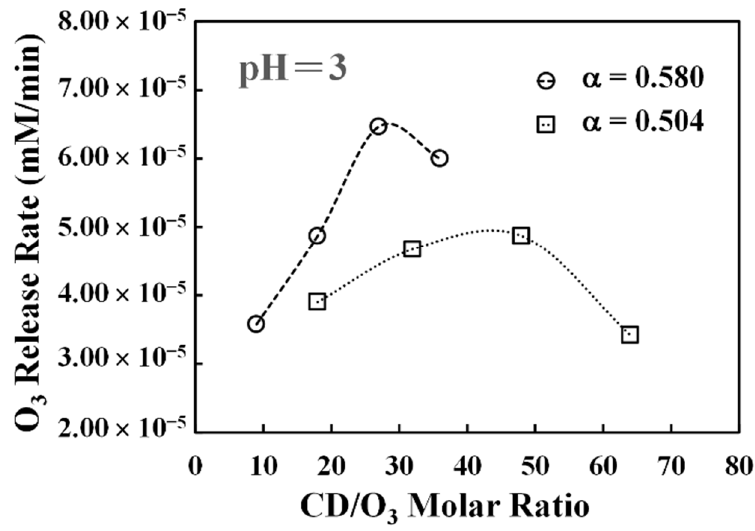
Figure 4. Data of Δ ABS as a function of time in ozone release experiments under a series of CD/O 3 molar ratios at two different ozone loading rates at pH 3: ( a ) α = 0.580; ( b ) α = 0.504.